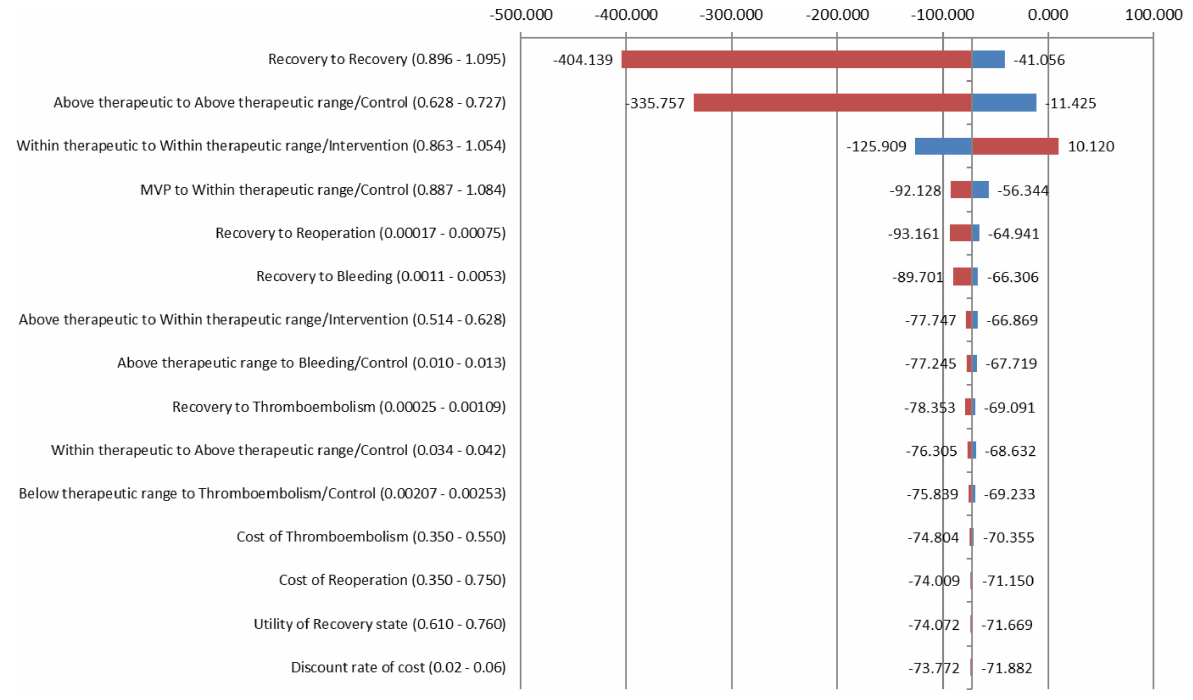
FIGURE 2 | Tornado diagram showing a series of one-way sensitivity